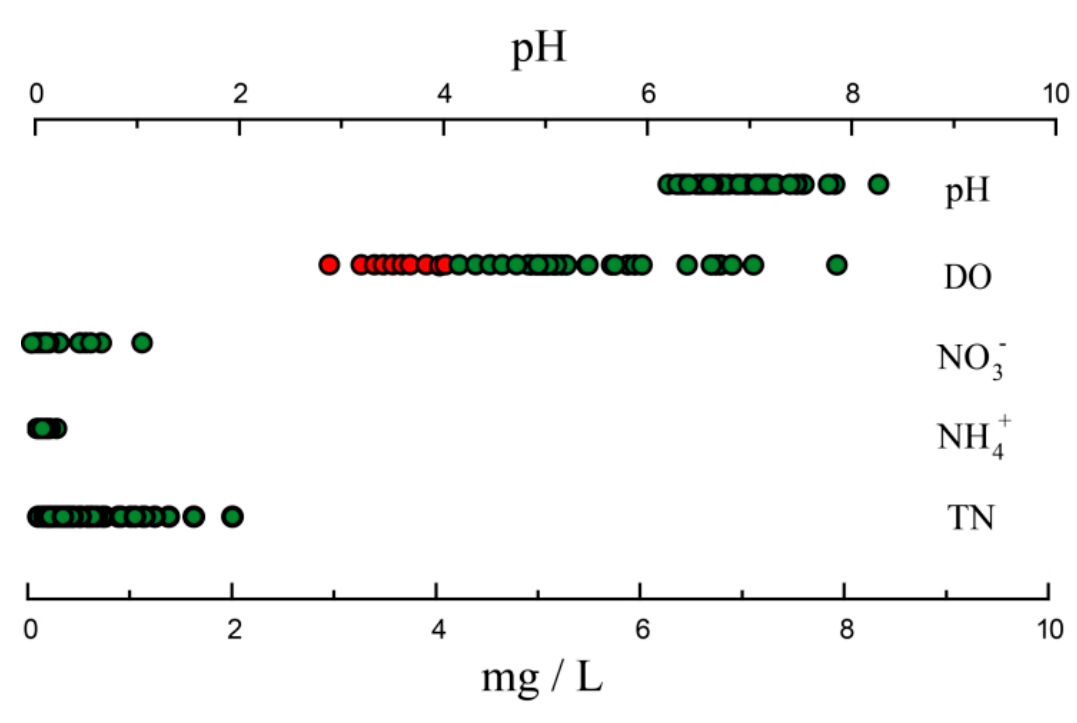
Figure 8. Water quality assessment of pH, DO, NO 3 − , NH 4+ , and TN in Mun River water. Based on the WHO and EC standard (pH, NO 3 − for the WHO standard and DO, NH 4+ , TN for the European Communities (EC) standard), the green point refers to water with good quality, the red point represents polluted water.